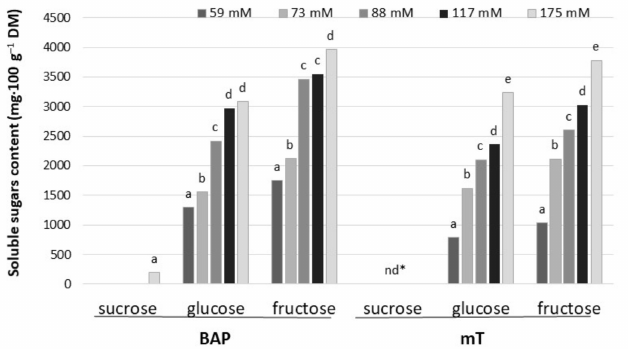
Figure 4. Contents of soluble sugars in culinary rhubarb ‘Malinowy’ after a 4-week subculture period in medium containing different cytokinin types: BAP (6.6 µ M) and mT (12.4 µ M) and sucrose levels (59, 73, 88, 117 and 175 mM); * not detectable. Duncan’s test was used independently for each type of cytokinin and sucrose concentration. Different letters indicate significant differences among sucrose treatments ( p = 0.05).